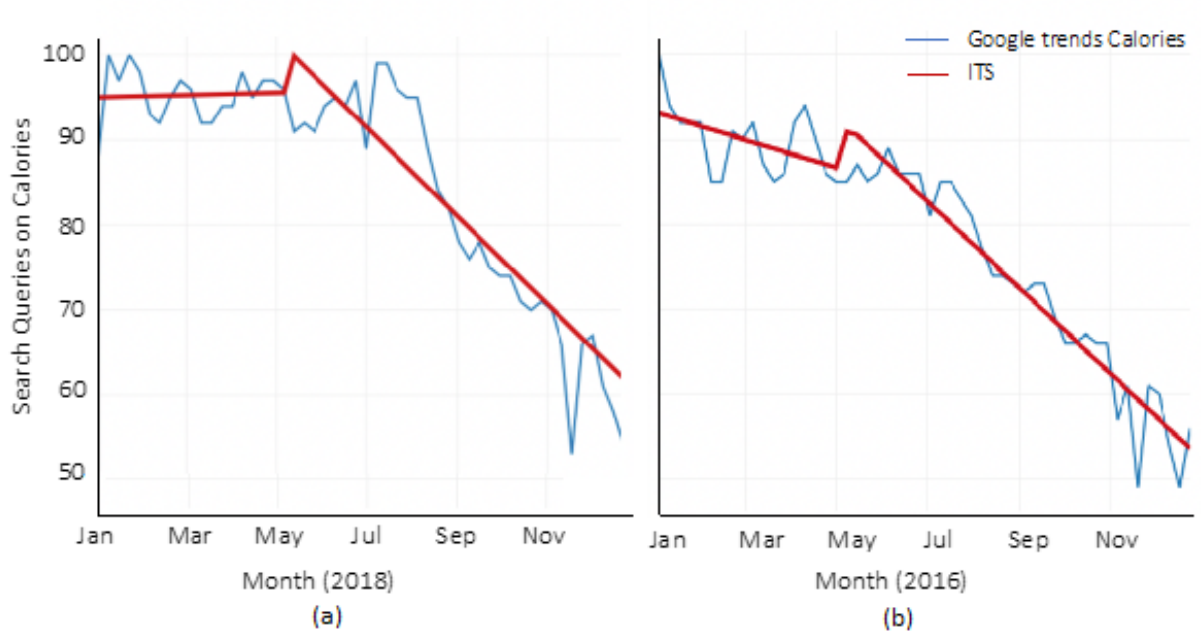
Figure 3. Interrupted time-series for Google Trends on Calories. ( a ) Year 2018, ( b ) Year 2016. Table 3. Parameter estimates, standard errors and p -values from the fitted segmented linear regression models of daily mean calorie(s) tweets in 2018 and 2016.